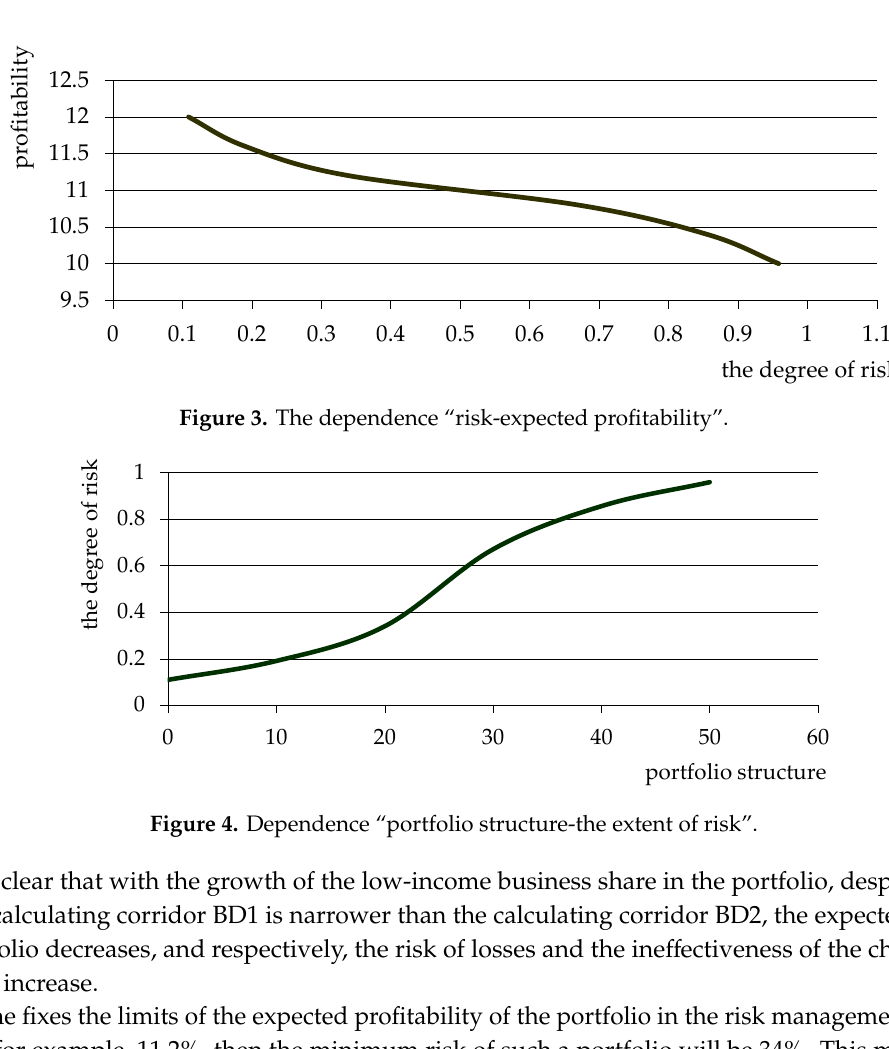
Figure 4. Dependence “portfolio structure-the extent of risk”.